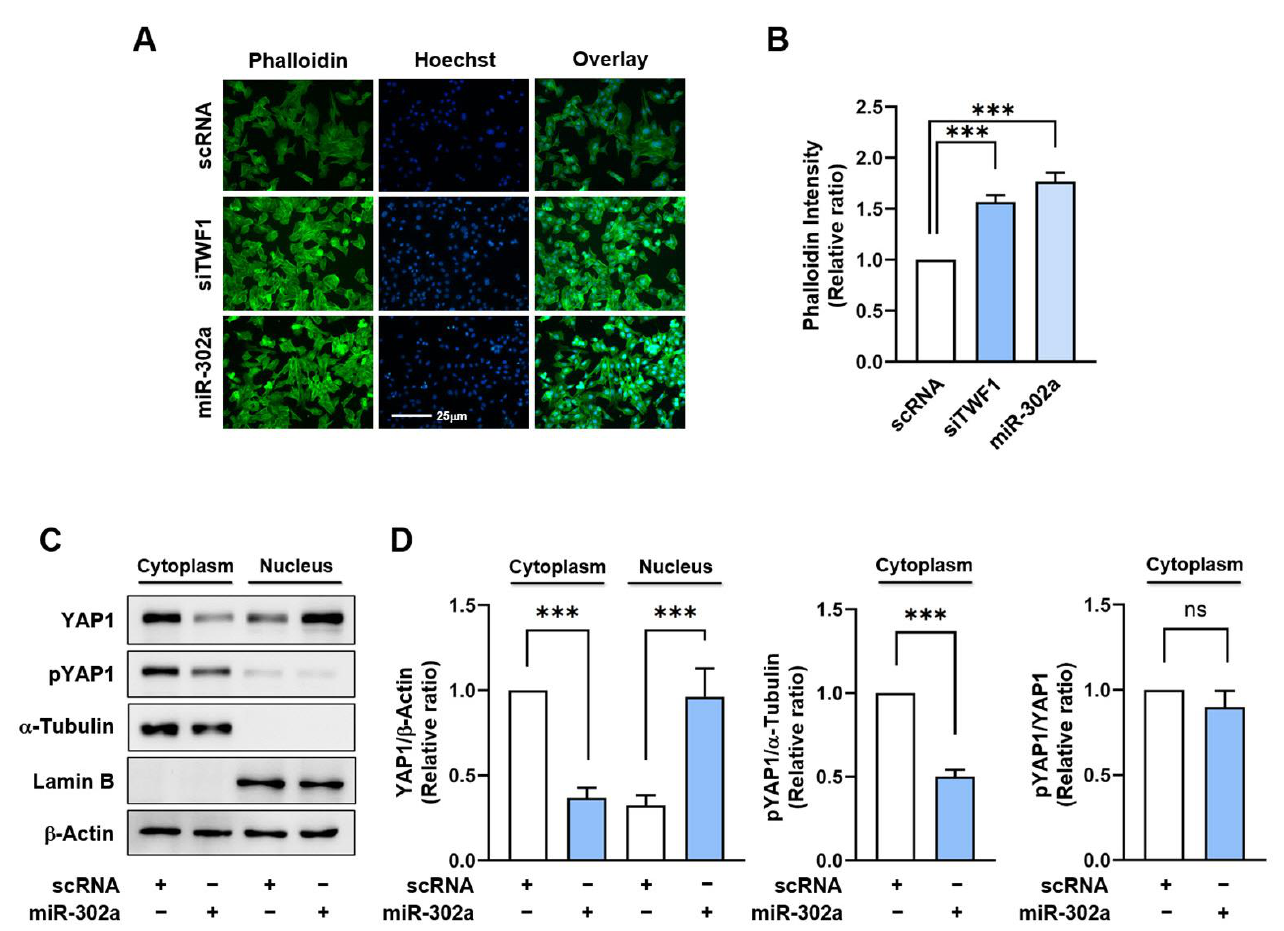
Figure 3. MiR-302a promotes F-actin formation and the nuclear localization of YAP1. C2C12 cells were transfected with scRNA, siTWF1, miR-302a mimic, or antimiR-302 for 24 h before analysis. ( A , B ) F-actin was stained with FITC-phalloidin (green). Nuclei were counterstained with Hoechst 34452 (blue). Scale bar: 25 µ m. ( C , D ) Immunoblots of YAP1 and phosphorylated YAP1 (pYAP1) in the nuclear and cytoplasmic fractions. α -Tubulin and Lamin B were applied as cytoplasmic and nuclear fraction markers, respectively. Immunoblot results are expressed as relative ratios versus Lamin B or α -Tubulin and presented as means ± standard errors ( n > 3); ***, p < 0.001 vs. scRNA. ns: no